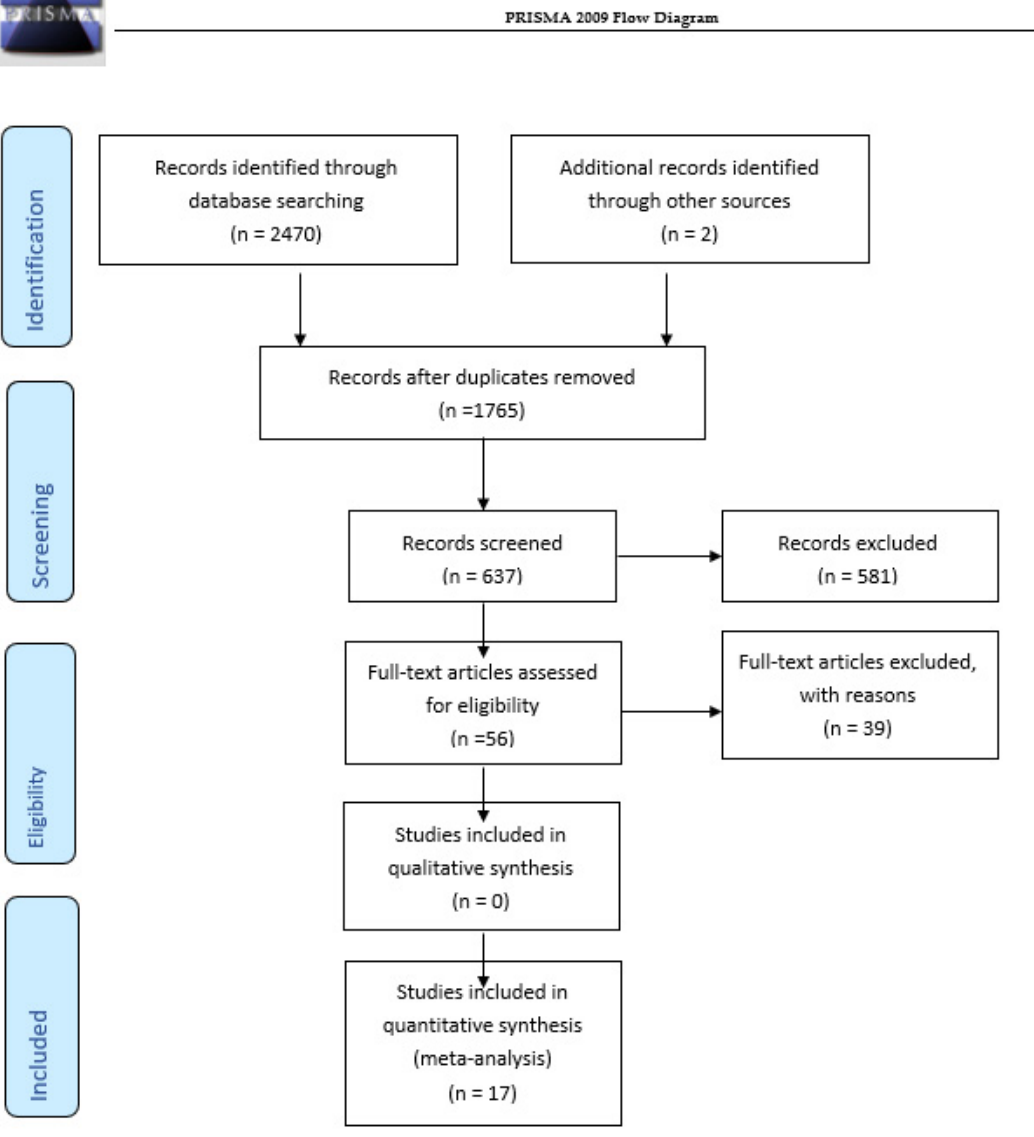
Figure 1. Flowchart for the systematic review procedure.